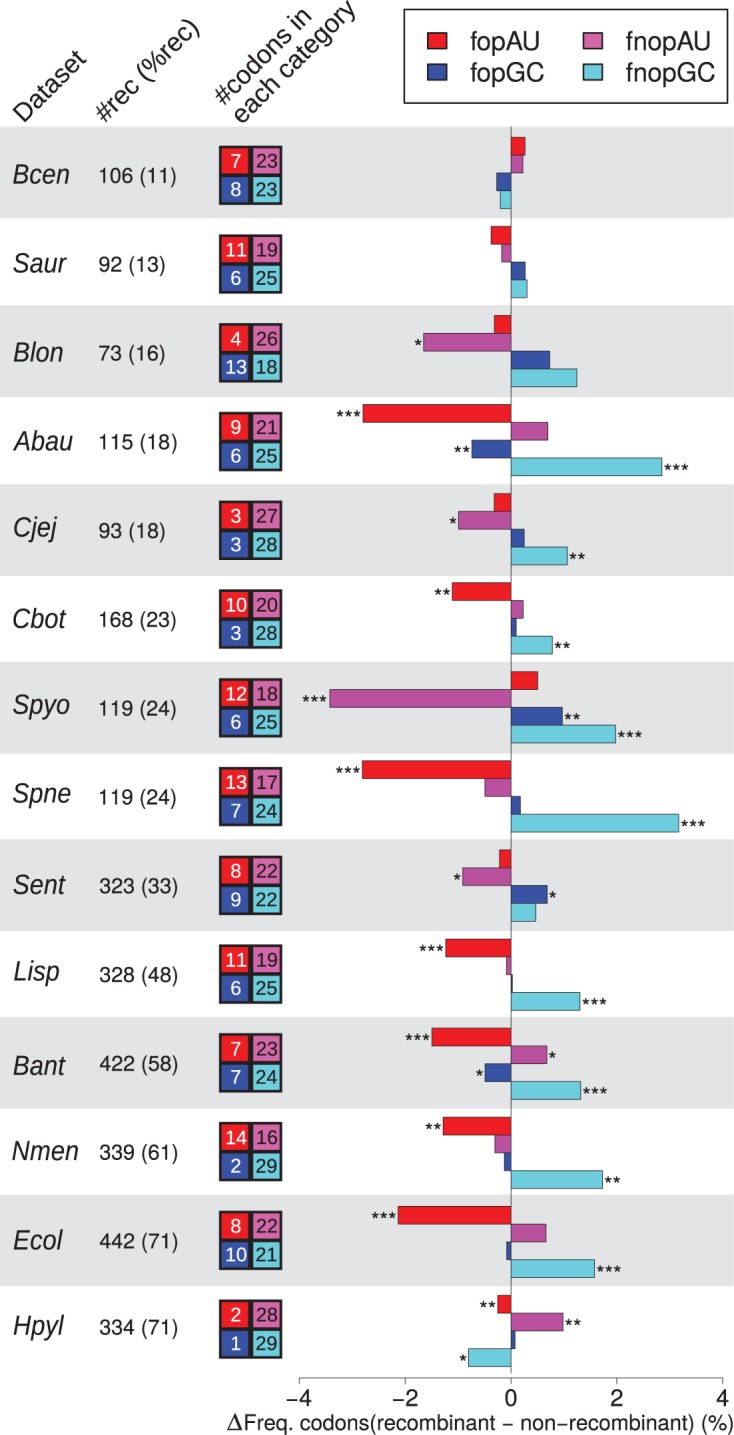
Effect of recombination on codon usage of core genes.Difference in frequency of optimal (fop) or non-optimal (fnop) codons (as determined by RP method) in recombining and non-recombining genes in each dataset for AU-ending (redish colors) and GC-ending (blueish colors) codons. The recombination status of genes was determined as in Fig. 1, only datasets with more than 10% recombining genes are shown. A positive difference indicates that recombining genes are enriched in a category of codons, while a negative difference indicate depletion. Stars indicate significance of a Student’s t-test between recombining and non recombining genes. Colored boxes on the right of dataset names indicate the numbers of AU-ending and GC-ending optimal or non-optimal codons used by the taxon (detailed in S2 Table). Symbols and dataset abbreviations as in Fig. 1; shading is only used to distinguish between datasets. It should be noticed that variations in fopGC and fnopAU (resp. fopAU and fnopGC) are not totally independent (typically, for all amino-acids encoded by two synonymous codons, if the optimal codon is GC ending, the non-optimal is AT-ending).